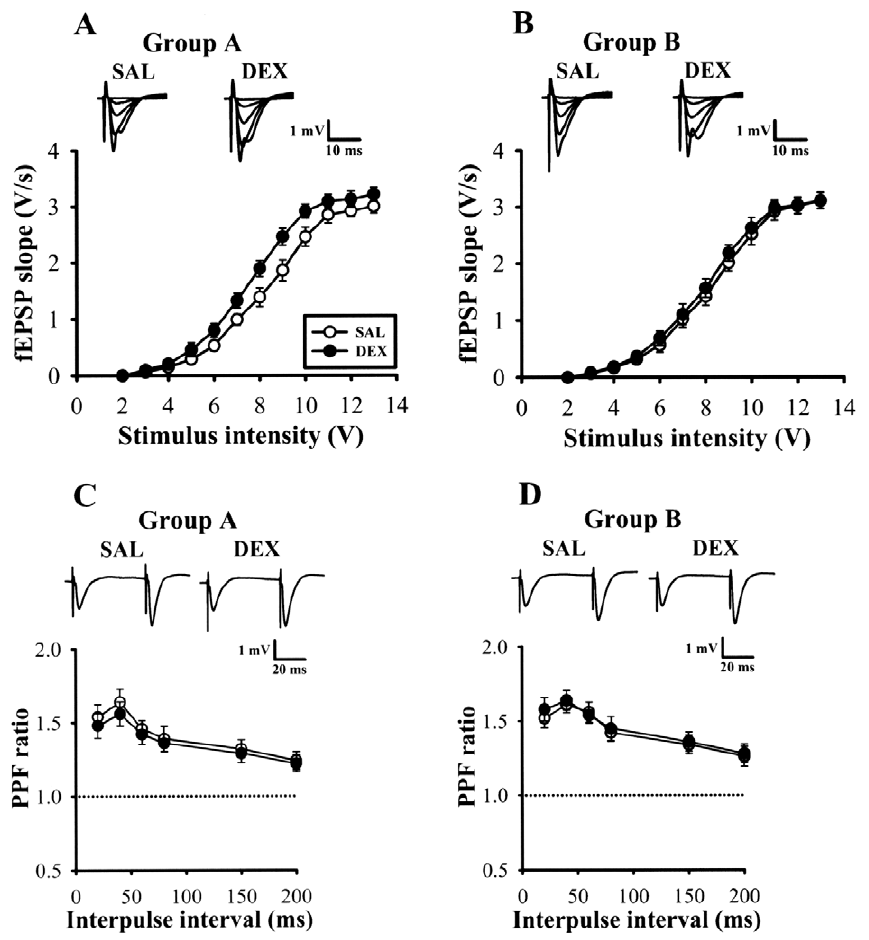
Figure 3. Culling reduces the effects of neonatal DEX treatment on basal synaptic transmission in hippocampal CA1 region. (A) Stimulus-response curve of fEPSP versus stimulus intensity at the Schaffer collateral-CA1 synapses of hippocampal slices from 5-week-old rats of Group A that received neonatal SAL (n=5) or DEX treatment (n=5). Inset shows overlaid traces (each an average of 3 responses) evoked in a slice from a SAL- (left set of traces) and DEX-treated (right set of traces) rats. (B) Stimulus-response curve of fEPSP versus stimulus intensity at the Schaffer collateral-CA1 synapses of hippocampal slices from 5-week-old rats of Group B that received neonatal SAL (n=5) or DEX treatment (n=5). (C) Comparison of PPF ratio in slices from 5-week-old rats of Group A that received neonatal SAL (n=5) or DEX treatment (n=5). The plot summarizes facilitation of the second fEPSP slope relative to the first one as a function of the interpulse intervals of 20–200 ms. The inset shows example PPF (average of 3 responses) obtained with interpulse interval of 40 ms in slices from SAL- and DEX-treated rats. (D) Comparison of PPF ratio in slices from 5-week-old rats of Group B that received neonatal SAL (n=5) or DEX treatment (n=5). Data represent the mean 6 SEM.